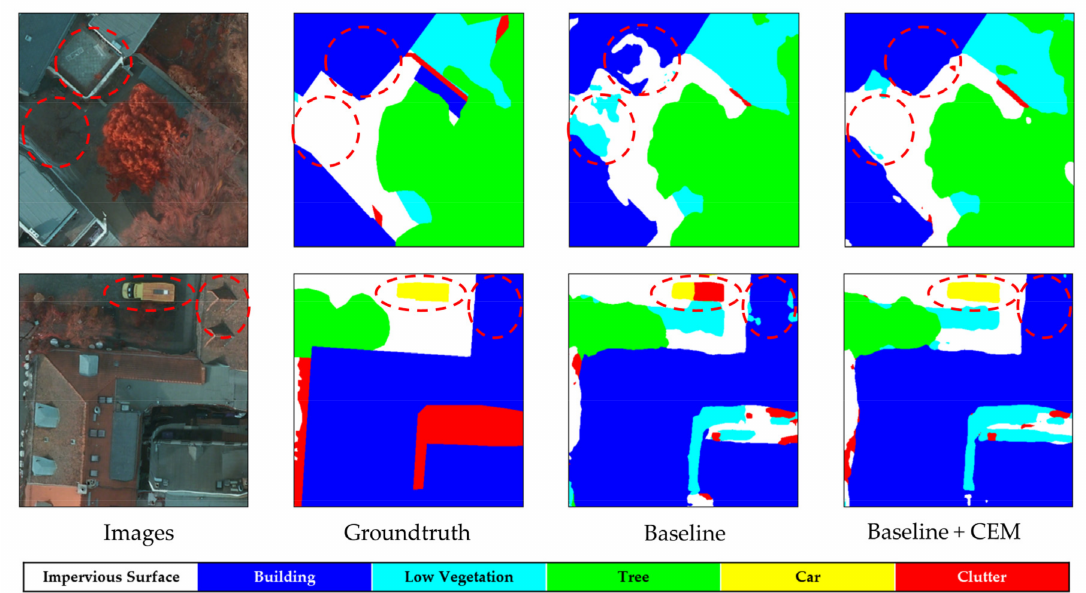
Figure 10. Qualitative comparisons between the baseline and the baseline with CEM. (From left to right ) Columns display the original images, the image ground truth, the predictions of baseline and the predictions of the baseline with